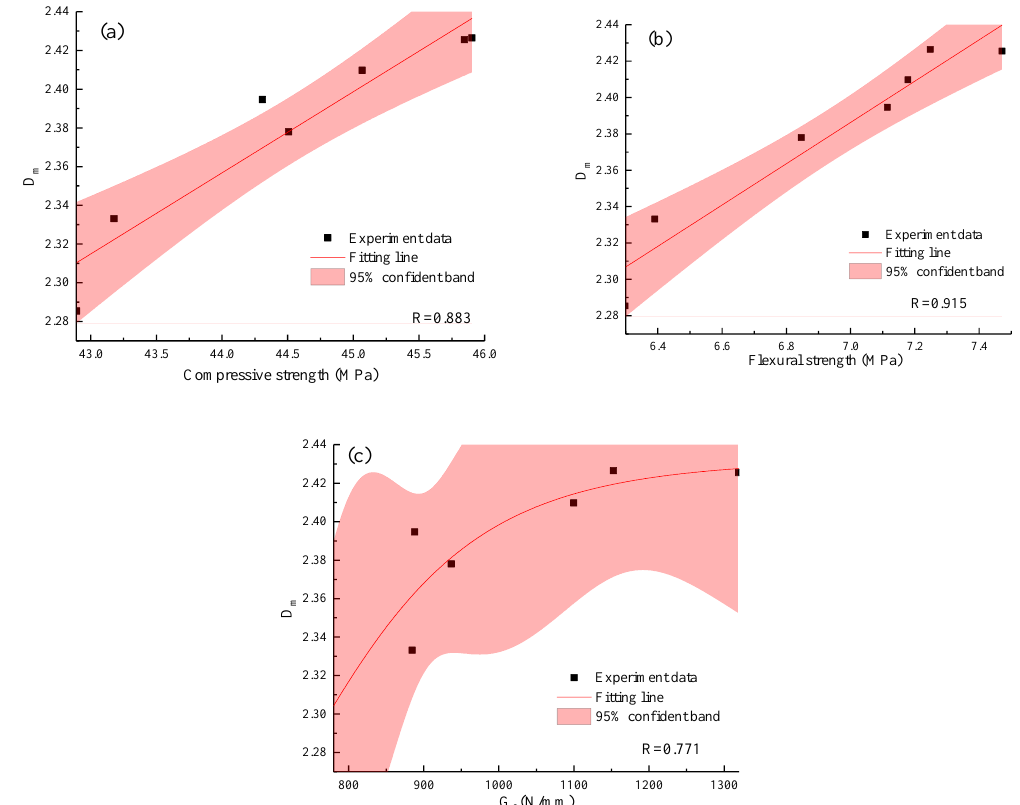
Figure 16. Relationship between D m with ( a ) compressive strength; ( b ) flexural strength; ( c ) fracture energy.